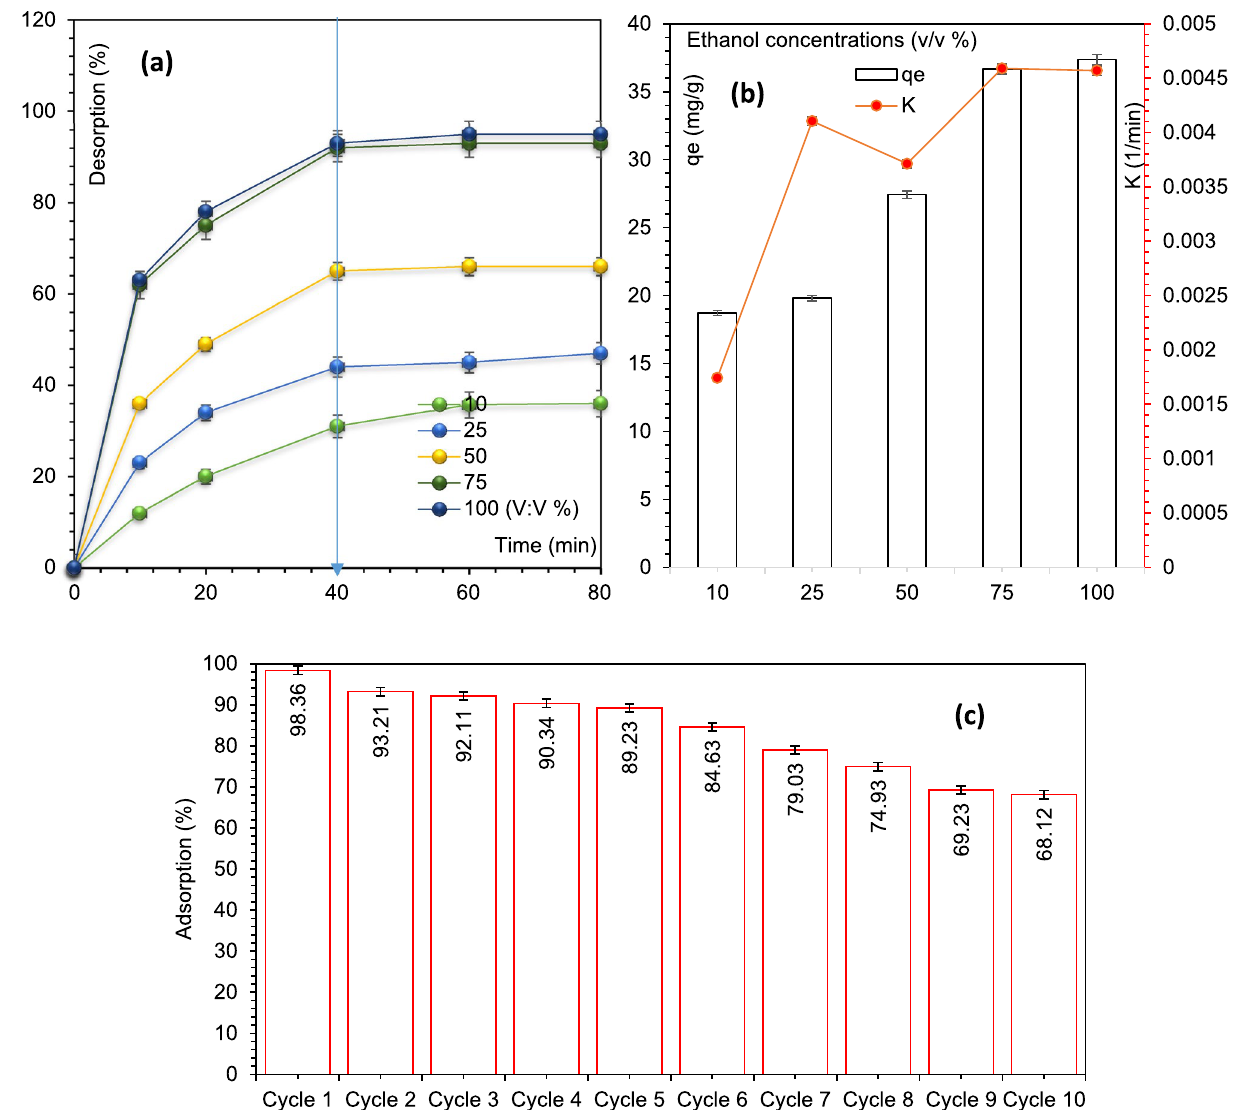
Figure 5. Desorption percentage of AZT at different ethanol concentration ( a ), desorption capacity and the rate of desorption under various ethanol concentrations ( b ) and reusability of MIL/Cs@Fe 3 O 4 NCs after AZT treatment for 10 cycles ( c